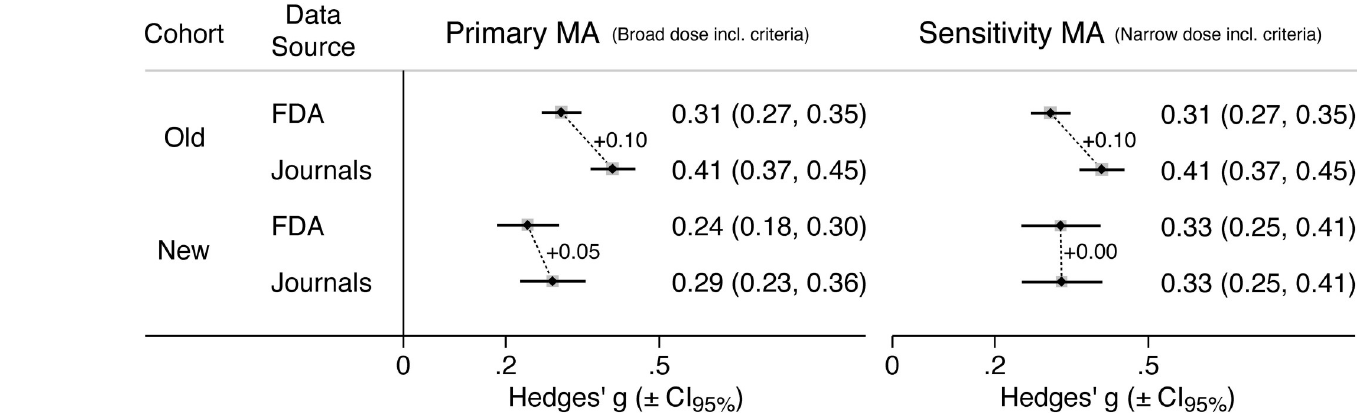
Fig 4. Comparison of overall ES, derived from FDA reviews vs. journal articles, for older and newer antidepressants. For the newer antidepressants, ESI was smaller than that previously reported for the older antidepressants. ES, effect size; ESI, effect size inflation; FDA, Food and Drug Administration; MA, meta-analysis.